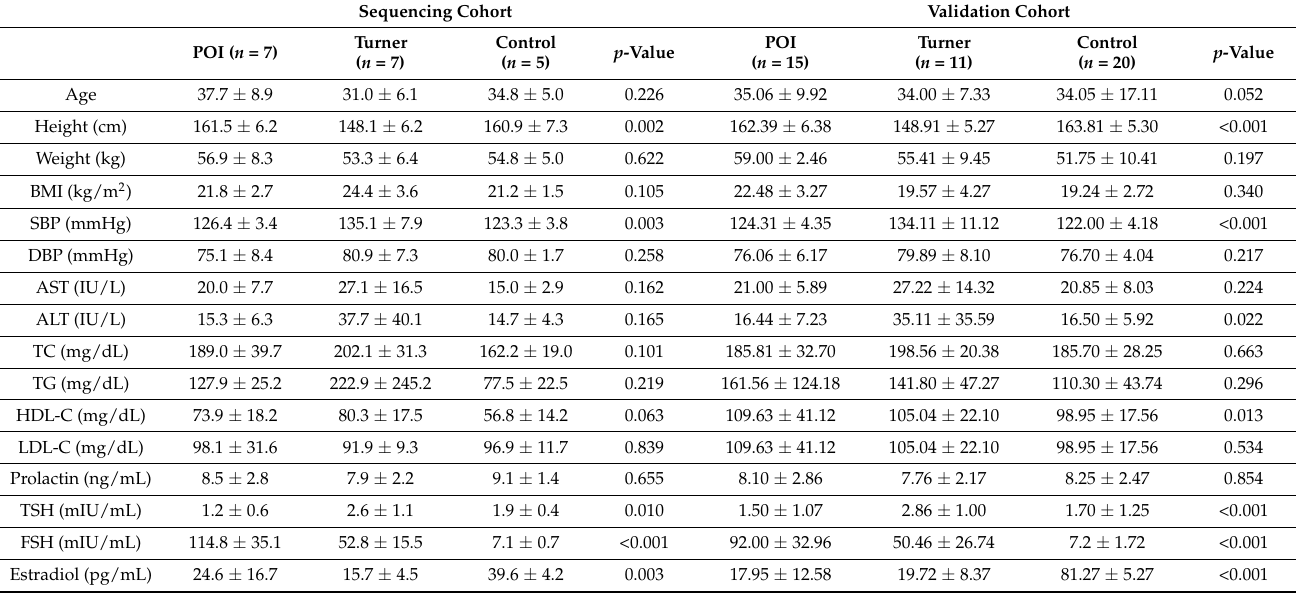
Table 2. Baseline clinical characteristics of the enrolled participants in the three groups.